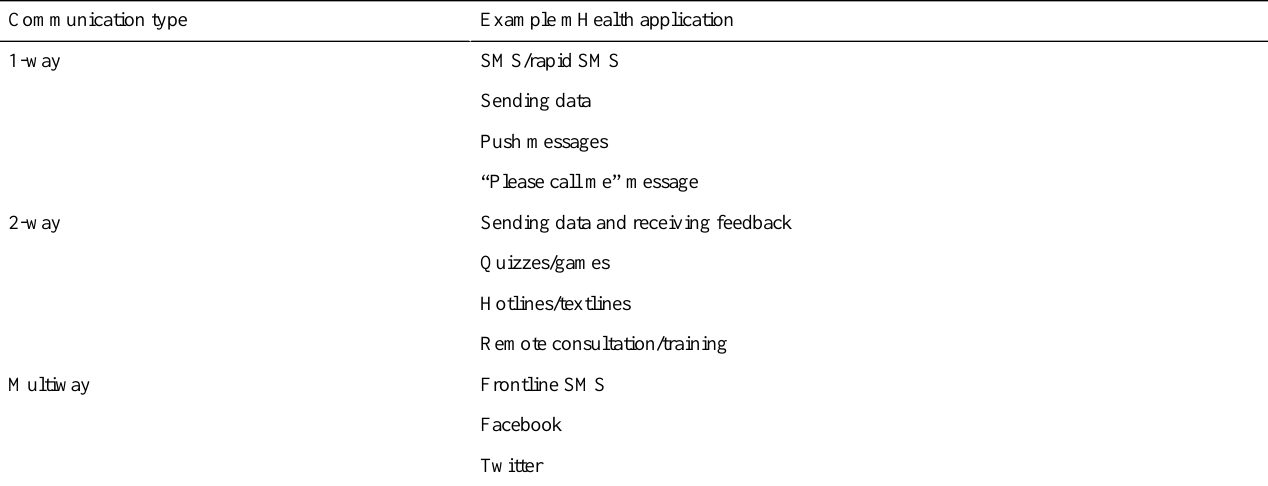
Table 3. Example of mHealth applications utilizing 1-way, 2-way, or multiway